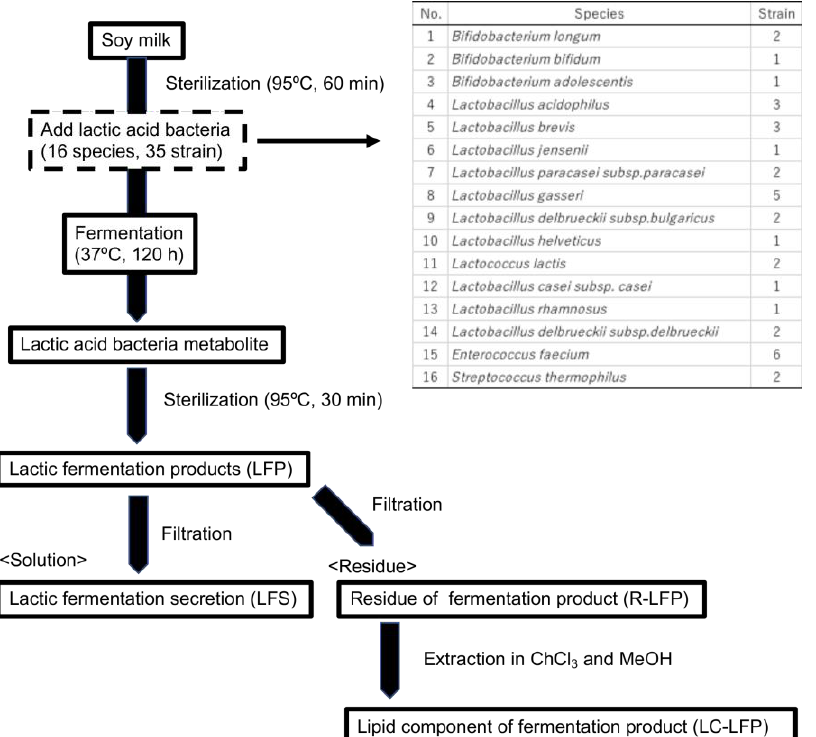
Figure 1. Method for the production of lactic acid bacteria metabolites and the species of microorganisms used.